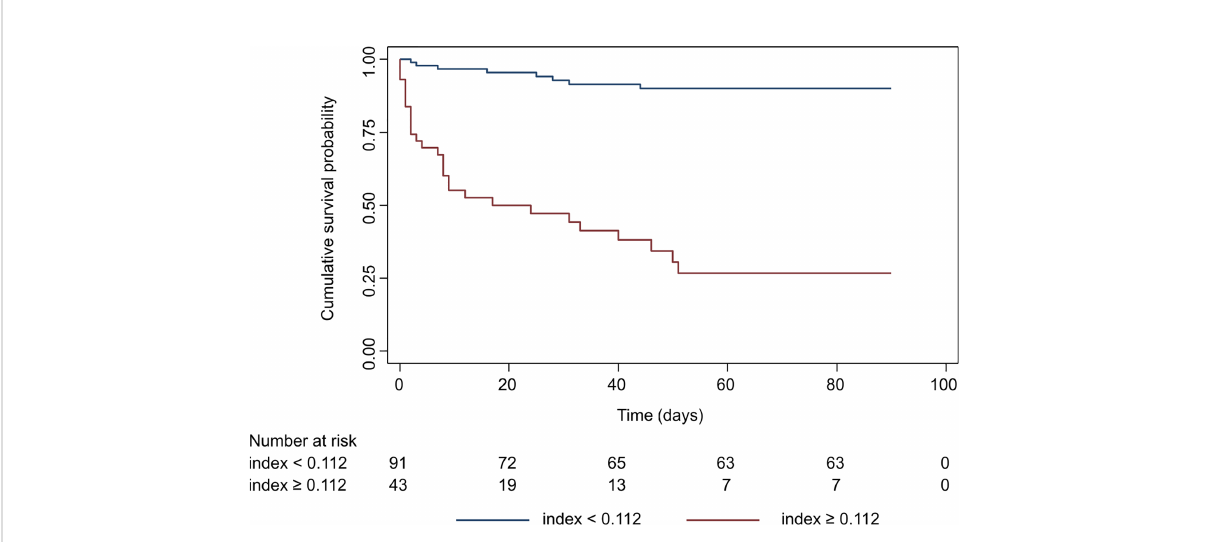
FIGURE 4 Kaplan-Meier survival curve of the prognostic index once dichotomized by maximally selected rank statistics. Patients were categorized in high and low mortality risk groups based on the threshold value of the prognostic index. Survival in the two groups was analyzed by Log-rank test ( p